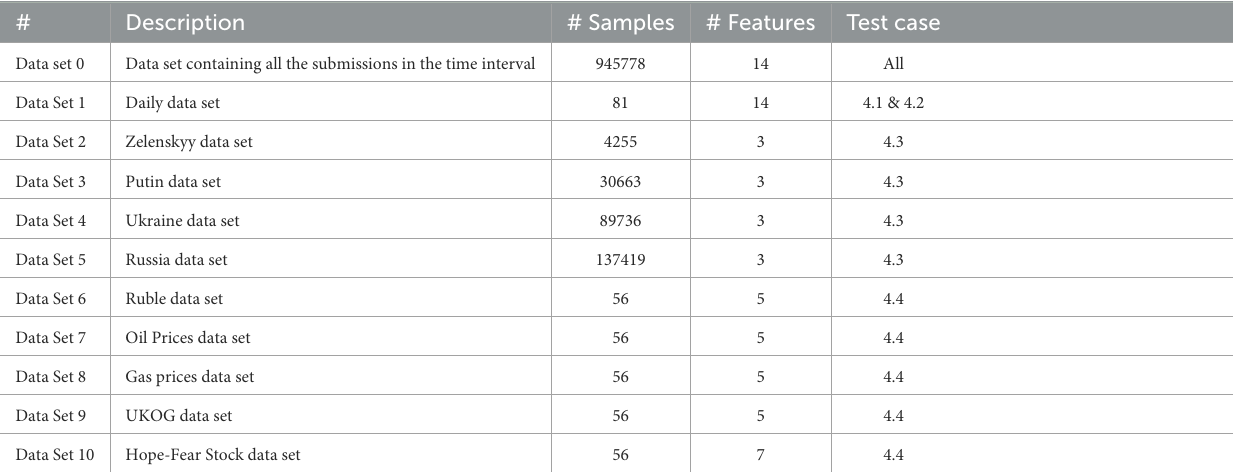
TABLE A1 All the data sets created for applications in Section